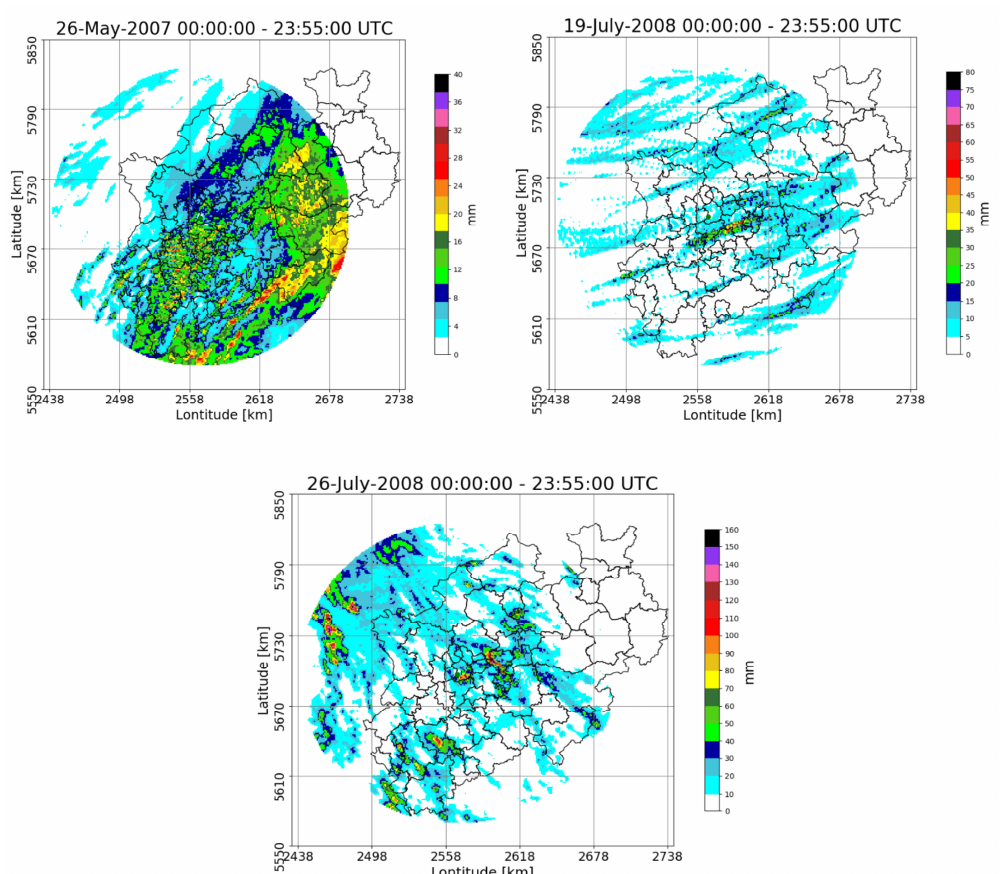
Figure 4. Daily rainfall distribution for selected rainy days. Radar reflectivity was converted into rain rate according to the German weather service standard Z–R relationship.